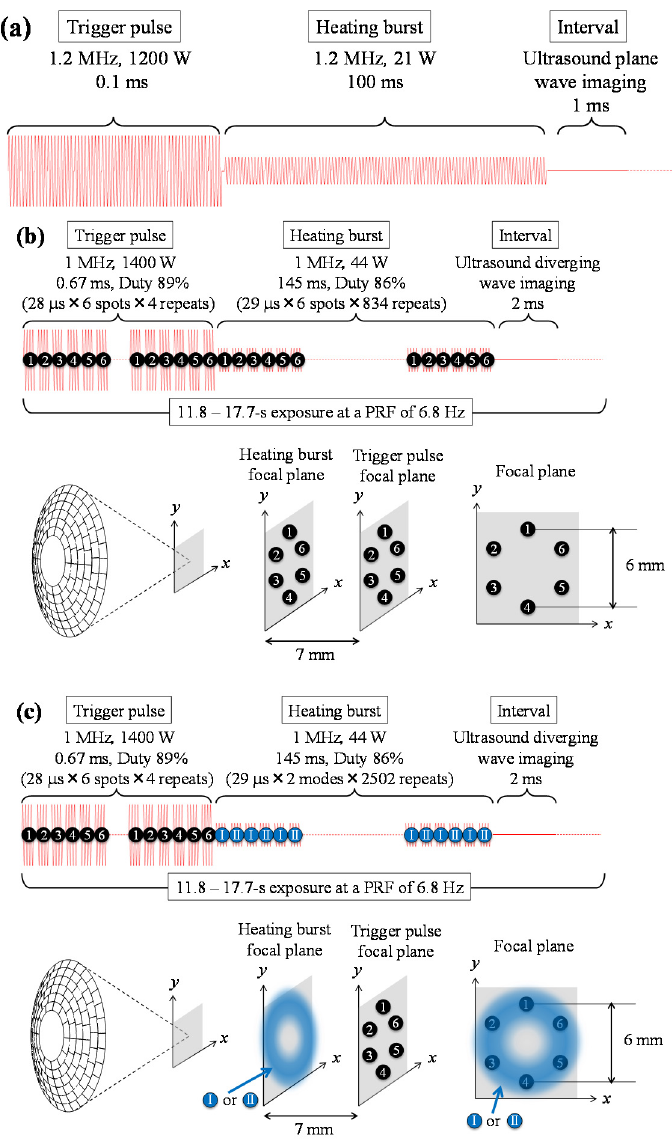
Figure 1. Schematic of three examples of a trigger high-intensity focused ultrasound (HIFU) sequence with intervals for ultrasonic imaging. ( a ) single spot focus sequence which is typically repeated for thermal treatments; ( b ) spot scanning trigger pulses followed by spot scanning heating bursts; ( c ) spot scanning trigger pulses followed by heating bursts with a directly synthesized focus with a ring shape to cover six foci of scanned trigger pulses. The focal plane of trigger pulses in ( b , c ) is shifted 7 mm forward from the geometric focal plane.